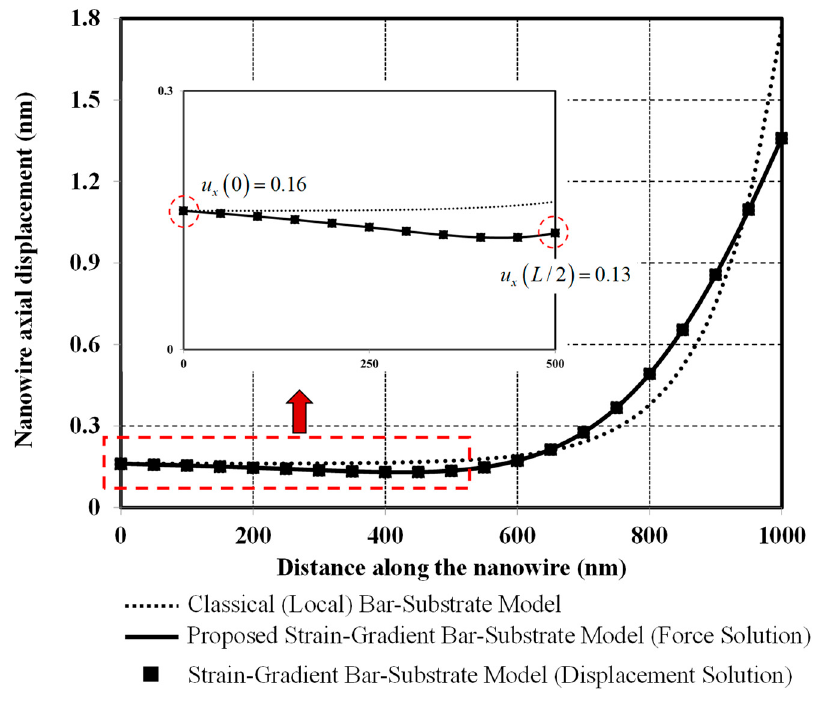
Figure 6. Axial displacement versus distance along the nanowire.